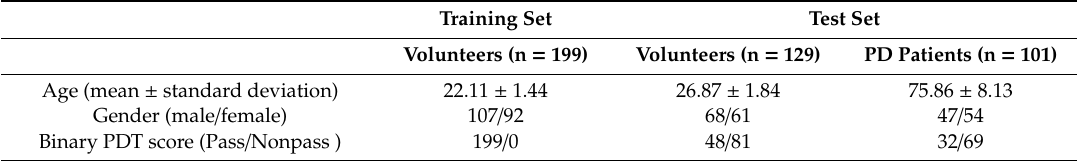
Table 1. Statistics of age, gender, handedness, and clinical status of the participants. Pentagon drawing test (PDT).